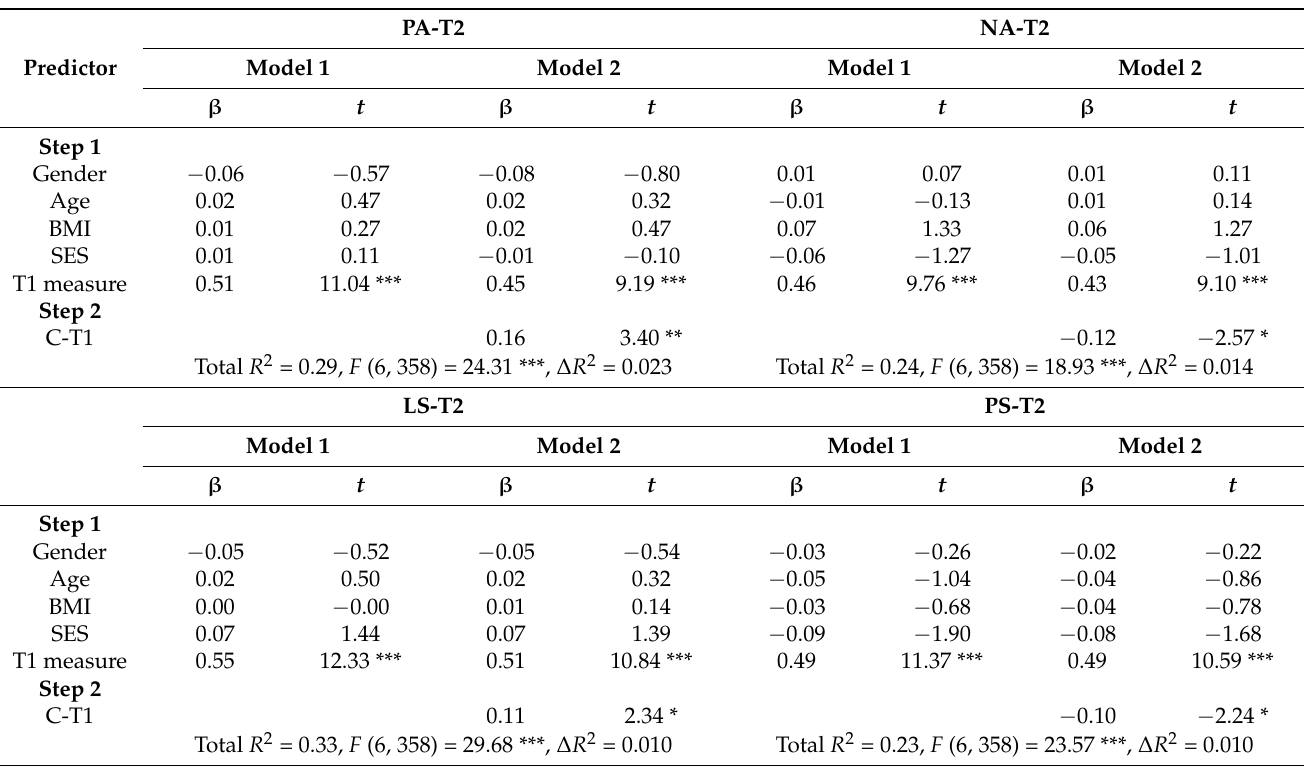
Table 3. Separate regression models for T1 conscientiousness predicting subjective and physical well-being at